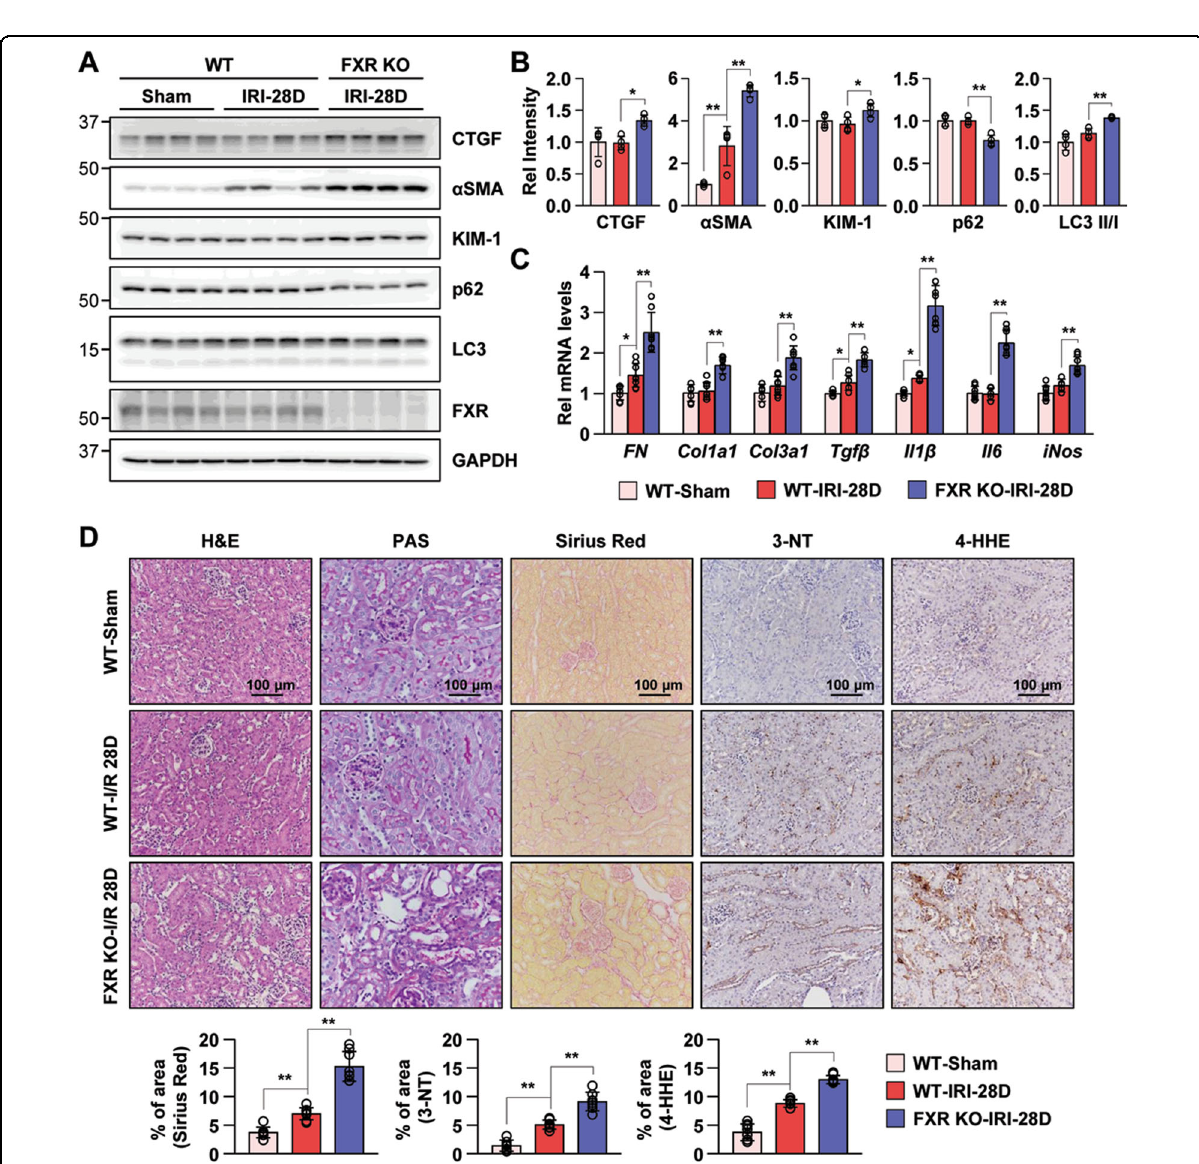
Fig. 8 Loss of FXR exacerbates progression to CKD after I/R-induced AKI. At 28 days after I/R, kidney samples were collected for measurements. A Protein levels of CTGF, α SMA, KIM-1, p62, LC3, and FXR were detected by immunoblotting. B The relative protein levels are shown. The values for the WT-Sham group were set to 1 ( n = 4). C mRNA levels were detected by qRT-PCR. The values for the WT-Sham were set to 1 ( n = 8). D Renal cortical tissues were collected for hematoxylin and eosin (H&E), periodic acid-Schiff (PAS) and Sirius Red staining to examine histology and for immunohistochemistry to examine the expression of 3-NT and 4-HHE. Computer-based morphometric analysis is shown (bottom bar graph, n = 7 – 8 in each group). All values are presented as the mean ± SD. Statistical signi fi cance was measured using one-way or two-way ANOVA with the Bonferroni post-test. * P < 0.05, ** P <